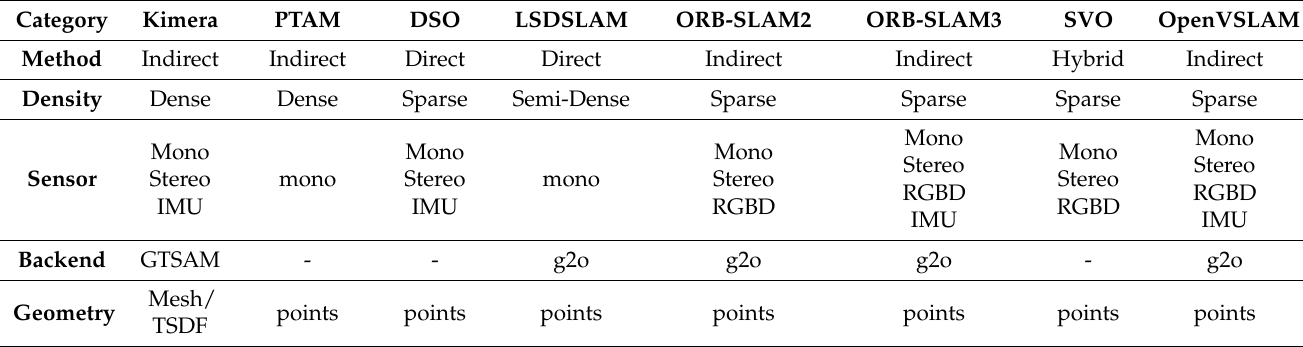
Table 1. Open-source-based visual SLAM